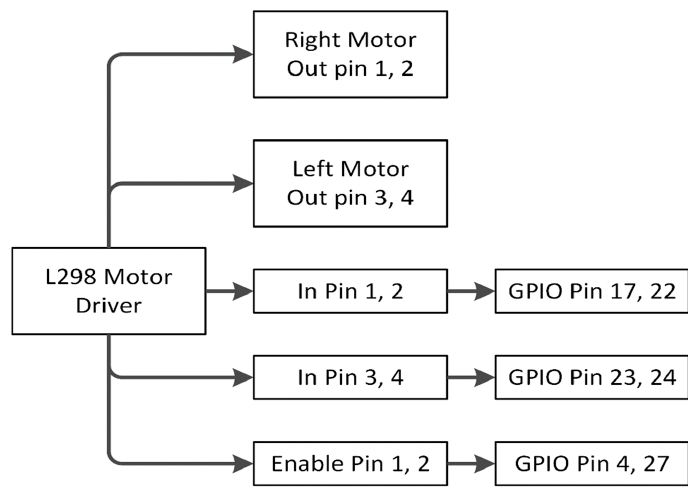
Figure 19. L298 Motor driver working process.